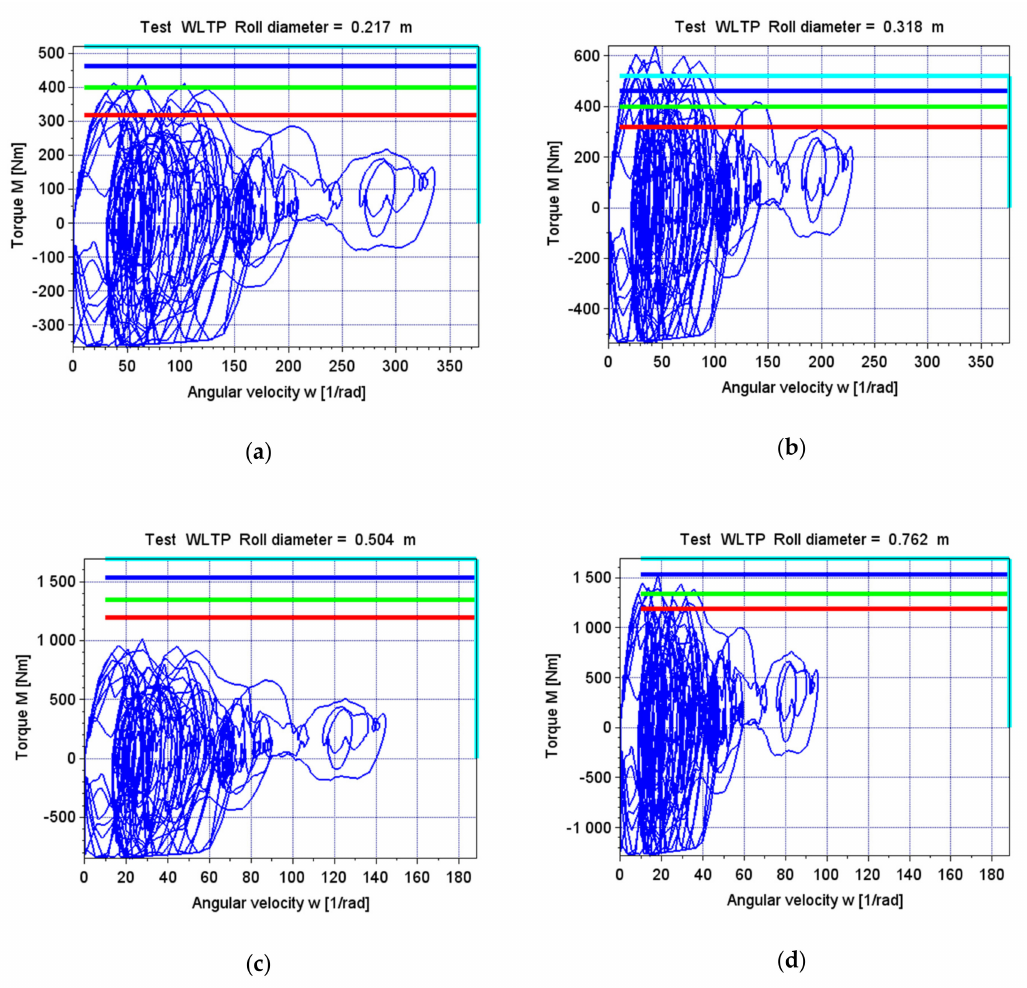
Figure 9. Simulation results for the WLTP test in the form of rotational speed and torque of the chassis dynamometer brake for changes in the diameter of the brake rollers: ( a ) 0.217 m—ECP 34-1S / 2—Power 120 kVA red line; ECP 34-2S / 2—Power 150 kVA green line; ECP34-1L / 2—Power 174 kVA blue line; ECP 34-2L / 2—Power 196 kVA light blue line; ( b ) 0.318 m—ECP 34-1S / 2—Power 120 kVA red line; ECP 34-2S / 2—Power 150 kVA green line; ECP34-1L / 2—Power 174 kVA blue line; ECP 34-2L / 2—Power 196 kVA light blue line; ( c ) 0.504 m—ECO38 1S4 A—Power 225 kVA red line; ECO38 2S4 A—Power 253 kVA green line; ECO38 3S4 A—Power 289 kVA blue line; ECO38 1L4 A—Power 319 kVA light blue line; ( d ) 0.762 m—ECO38 1S4 A—Power 225 kVA red line; ECO38 2S4 A—Power 253 kVA green line; ECO38 3S4 A—Power 289 kVA blue line; ECO38 1L4 A—Power 319 kVA light blue